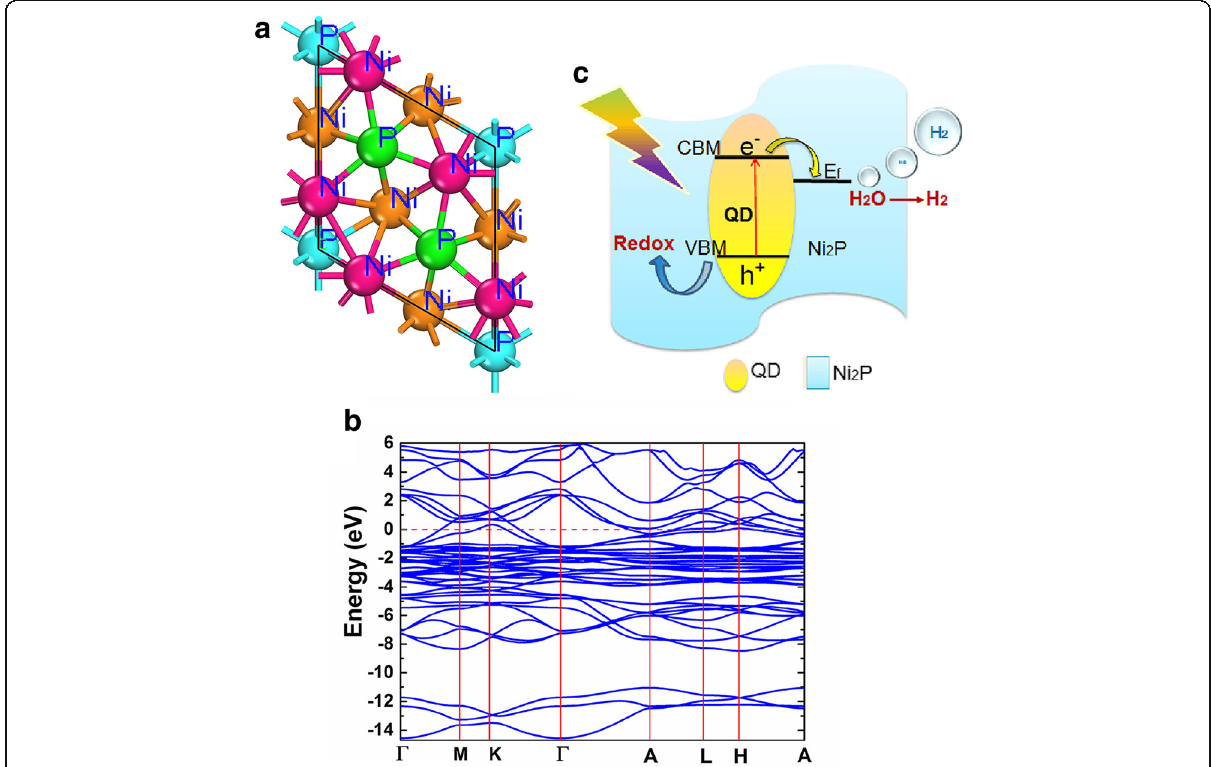
Fig. 5 The band diagram and charge separation and transfer mechanism for the photocatalytic H 2 evolution. a Top views of the ball and stick model of (001) surface-terminated bulk Ni 2 P. b Calculated band structure of Ni 2 P where the red dash line represents Fermi level. c Schematic mechanism illustrating the charge separation and transfer for the photocatalytic H 2